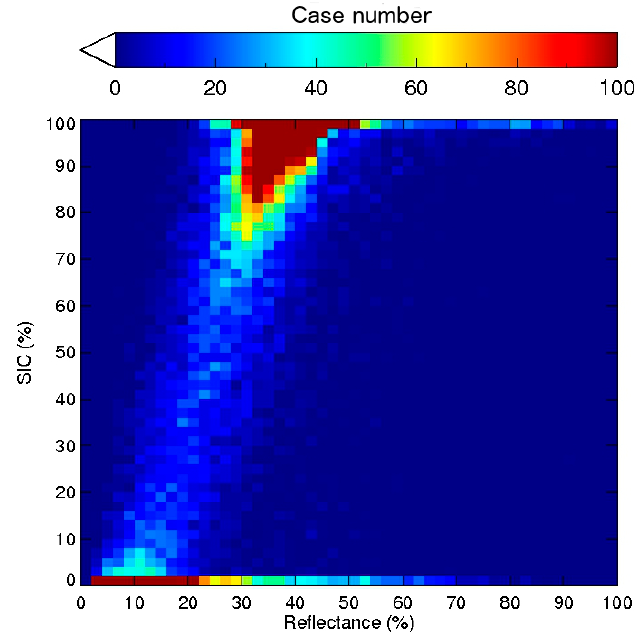
Figure 5. Reflectance and sea ice concentration (SIC) relative frequency distribution at 0.64 μ m for Landsat ice cover in Figure 2.